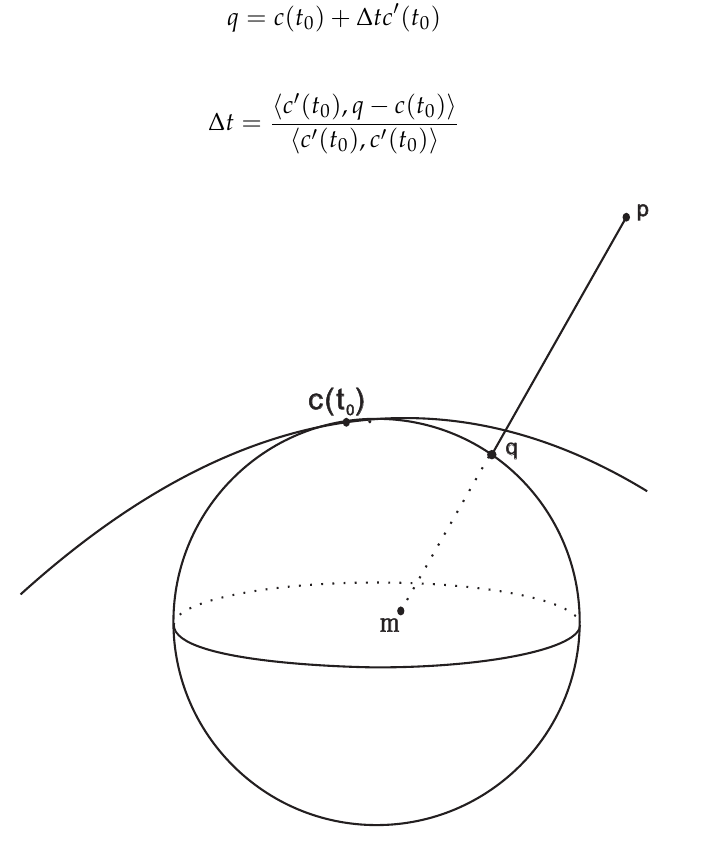
Figure 1. Illustration of the first-order geometric iteration for computing the minimum distance between a point and a spatial parametric